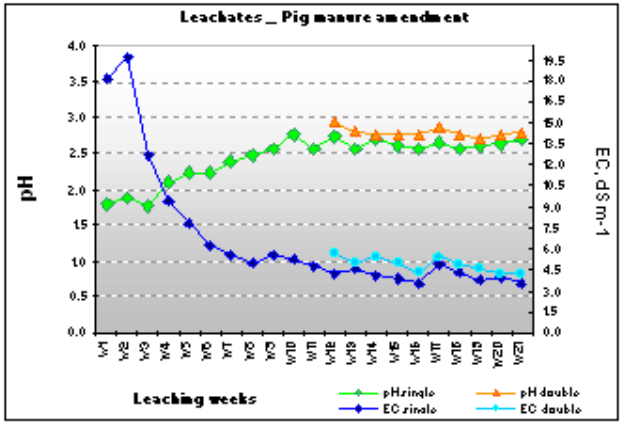
FIGURE 9 . pH and EC in the leachates from the column leaching studies.